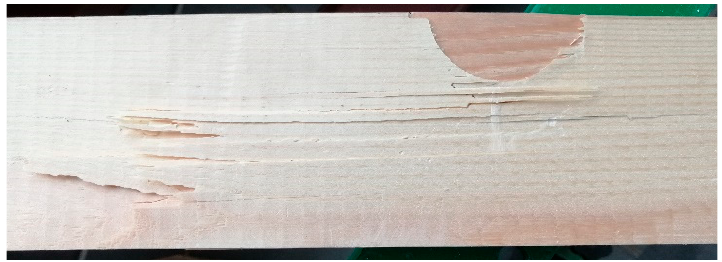
Figure 7. Example of a damaged specimen containing a semi-circular insertion. Although the number of specimens is small (12 per set), the decrease in strength of the specimens without inserts is not only the result of a reduction in the cross-section of the analysed samples. By cutting out part of the timber, the fibres are cut. There is some disruption of the structure of the lumber in this section, and there is a notch-like effect. By gluing the material in this area using the finger joint, some improvement in strength is achieved (Set_4 = 90.3 N/mm2 against Set_5 = 68 N/mm 2 ). However, despite the demonstrated lack of differences, it must be assumed that the effect is also dependent on the wood’s structure (grain arrangement) at the defect repair site. Additionally, ultimately, one should not count on achieving a load-bearing capacity similar to that of wood without defects. The test results described above, due to the small number of tests carried out, should be regarded as an indication of how individual batches of lumber may behave rather than an attempt to indicate specific values for static bending strength. When preparing the lumber sets for the manufacturing of the beams, as mentioned in the methodology for the first assumption, lumber with a high modulus of elasticity and no edge defects was selected for the outer layer. A sorter assessed each piece. Table 1 shows the average moduli of elasticity of the lamellas used in the study, arranged in the different layers of the beams manufactured. Lam. 1 is the outer lamella of the tension zone. As seen from the data in Table 1, the arrangement of the layers on the tensile side in the designed beams is similar. Nevertheless, the best strength effects are expected from the SW_M set and the lowest from the P2 set. However, this arrangement of layers should allow for strengths above 30 MPa in each set.